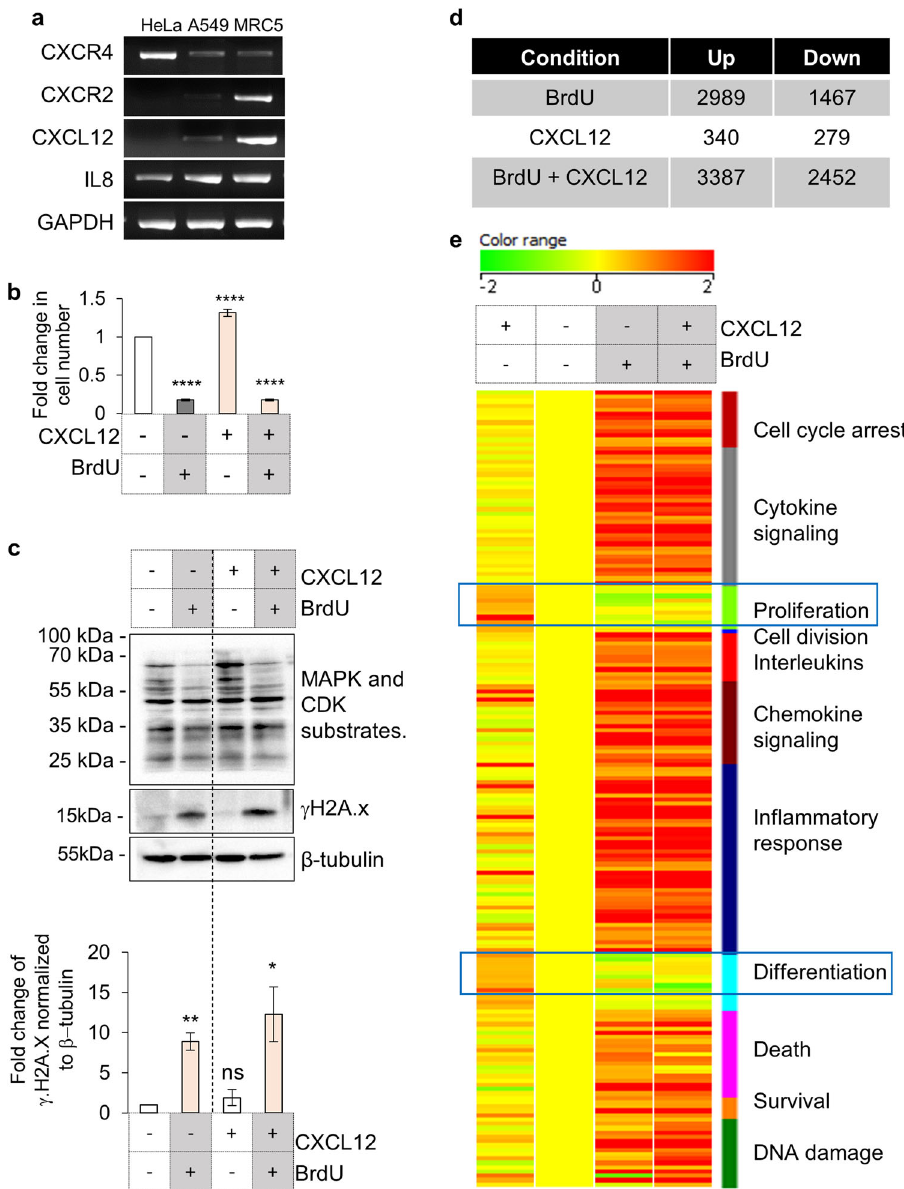
Fig. 3 Analysis of effects of CXCR4 activation in damaged cells. a Gene expression analysis to evaluate transcription of CXCR4 and CXCR2 and respective ligands by PCR. Expression analysis of mentioned genes was performed in HeLa, A549 and MRC5 cells (Table S2). b Effect of CXCL12-CXCR4 axis on cellular proliferation. HeLa cells, with or without CXCL12 (200 ng/ml) or BrdU were counted after 72 h of treatment. The Y -axis represents fold change of proliferative index wrt undamaged unstimulated cells. Results are mean ± s.e.m. **** p ≤ 0.0001 (Student ’ s t - test; n > 10). c Analysis for γ H2A.x and MAPK/CDK substrate phosphorylation on activation of CXCR4 receptor. HeLa were treated with CXCL12 (200 ng/ml) in presence or absence of 100 µM BrdU for 48 h and the levels of MAPK-CDK substrates (top), phospho-H2Ax (middle panel) and β - tubulin (bottom) were analyzed by western blotting. Quantitation of γ H2Ax levels are shown in the graph ( n = 3). d Microarray analysis of gene expression changes in response to CXCL12 treatment. Table shows number of gene up or downregulated in comparison to